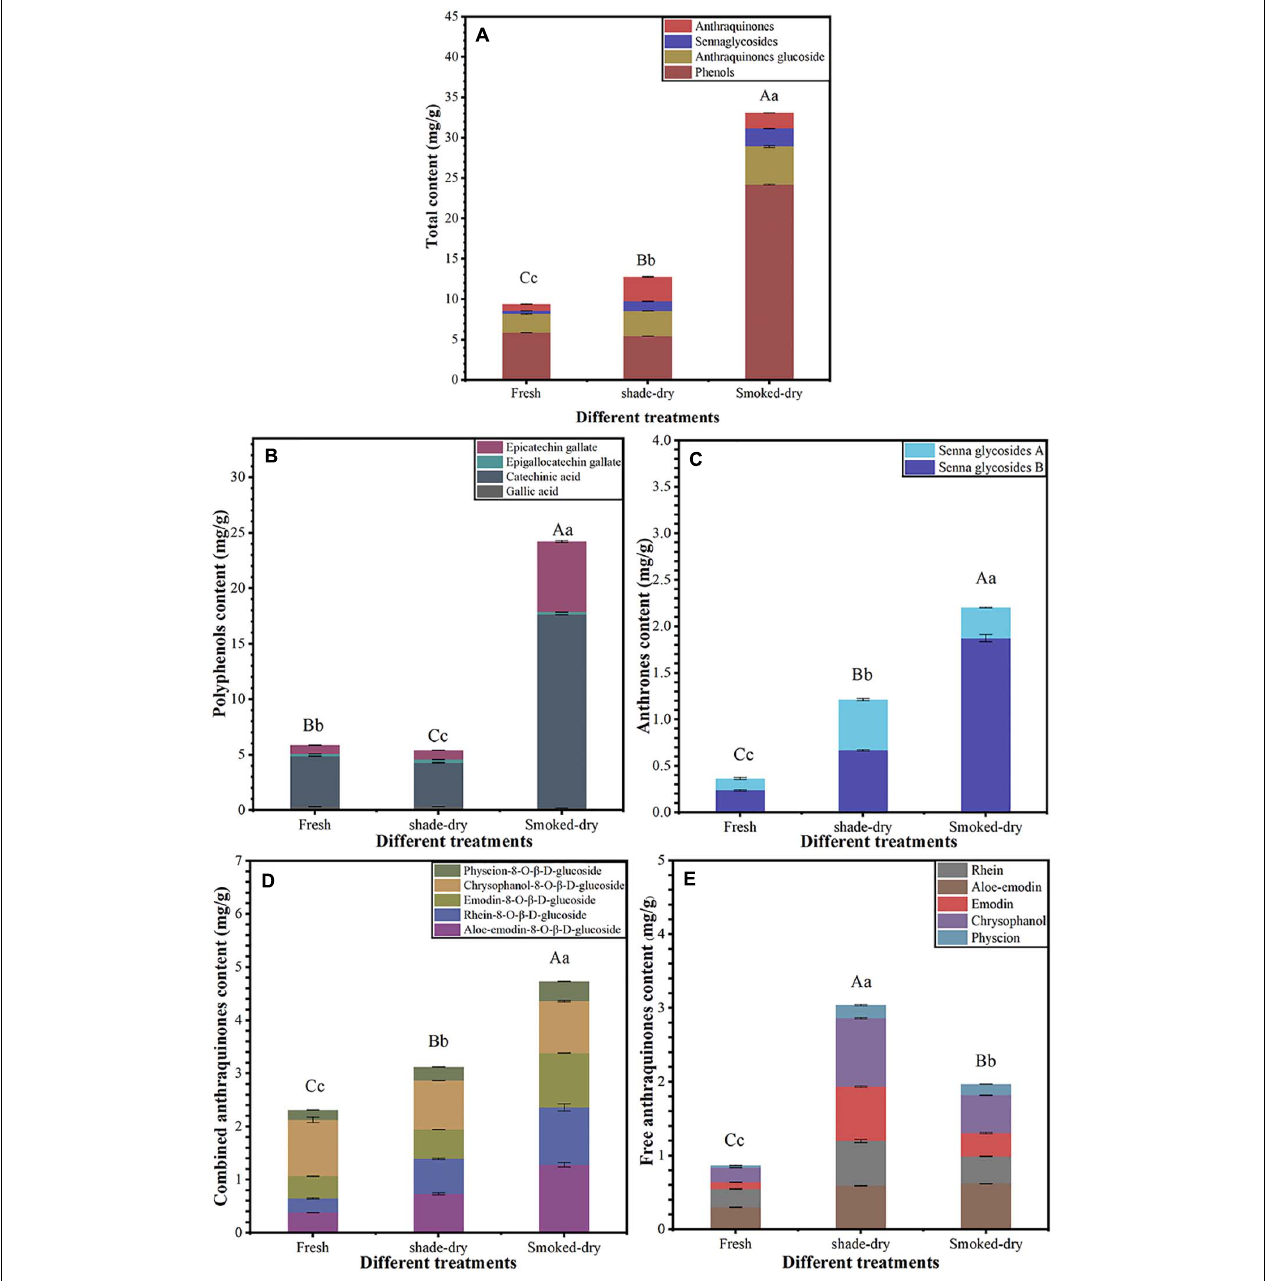
FIGURE 1 | Sixteen active ingredient analysis of fresh rhubarbs, shade-drying, and smoke-drying. (A) The total content of active ingredients at the different dry method, (B) polyphenols content, (C) anthrones content, (D) combined anthraquinones content, (E) free anthraquinones content. The error bars represent the means ± SE ( n = 3). The degree of freedom between groups is 8. Perform ANOVA on total content, polyphenols content, anthrones content, combined anthraquinones content, and free anthraquinones content, respectively. Different letters indicate a significant difference (capital letters p < 0.01, small letters p <